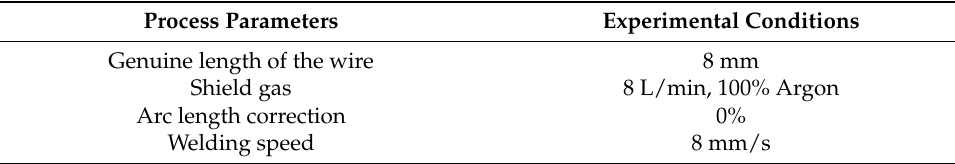
Table 3. Preconditions of the experimental process parameters for CMT welding.